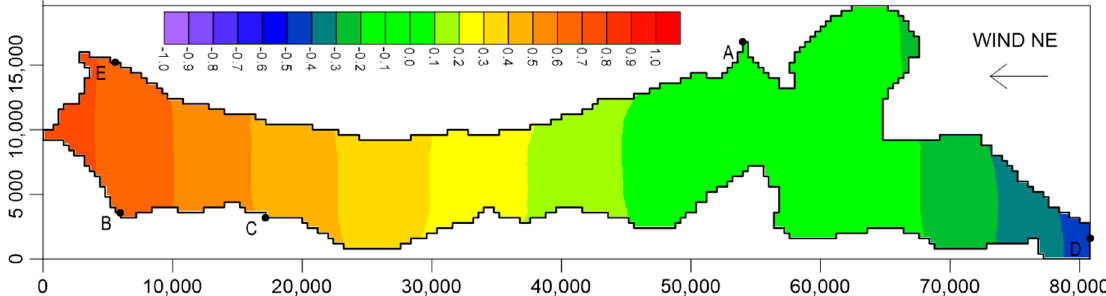
Figure 7. Water surface elevation (m a.s.l.) after 12 hours of a NE wind at a speed of 12 m s -1 and without the new artificial strait at point E (dimensions in meters).